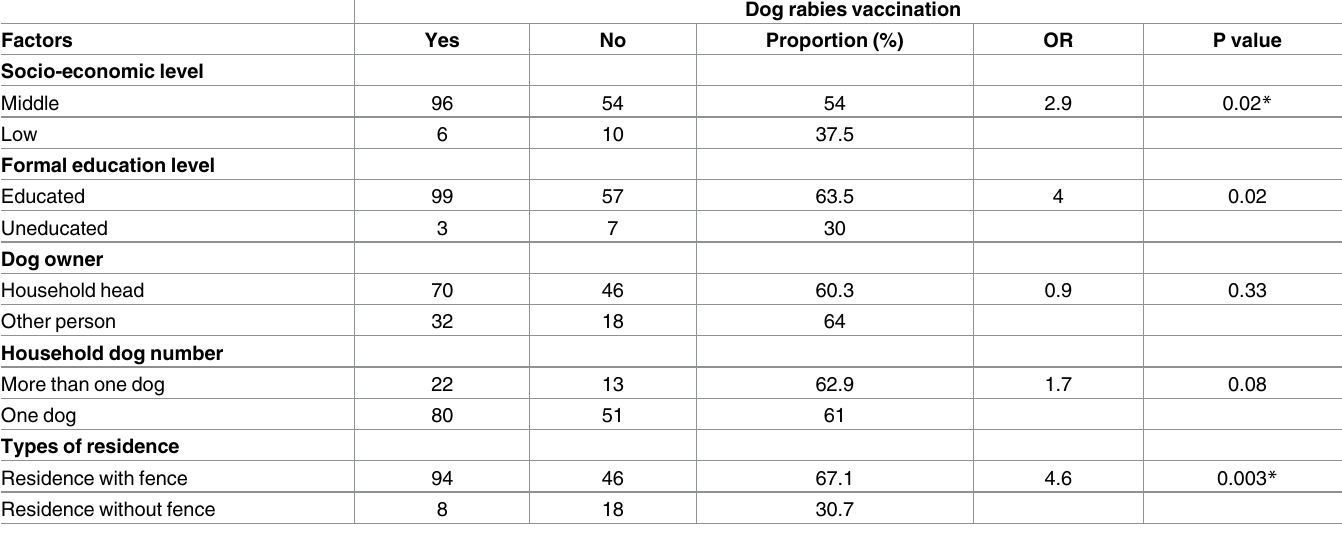
Table 1. Dog-owning households’ characteristics associated to dog rabies vaccination.